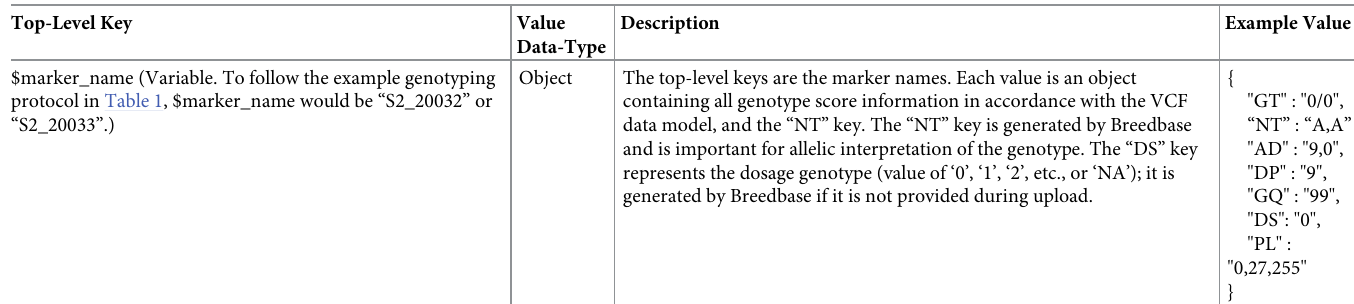
Table 2. Description of JSON object stored in the genotypeprop